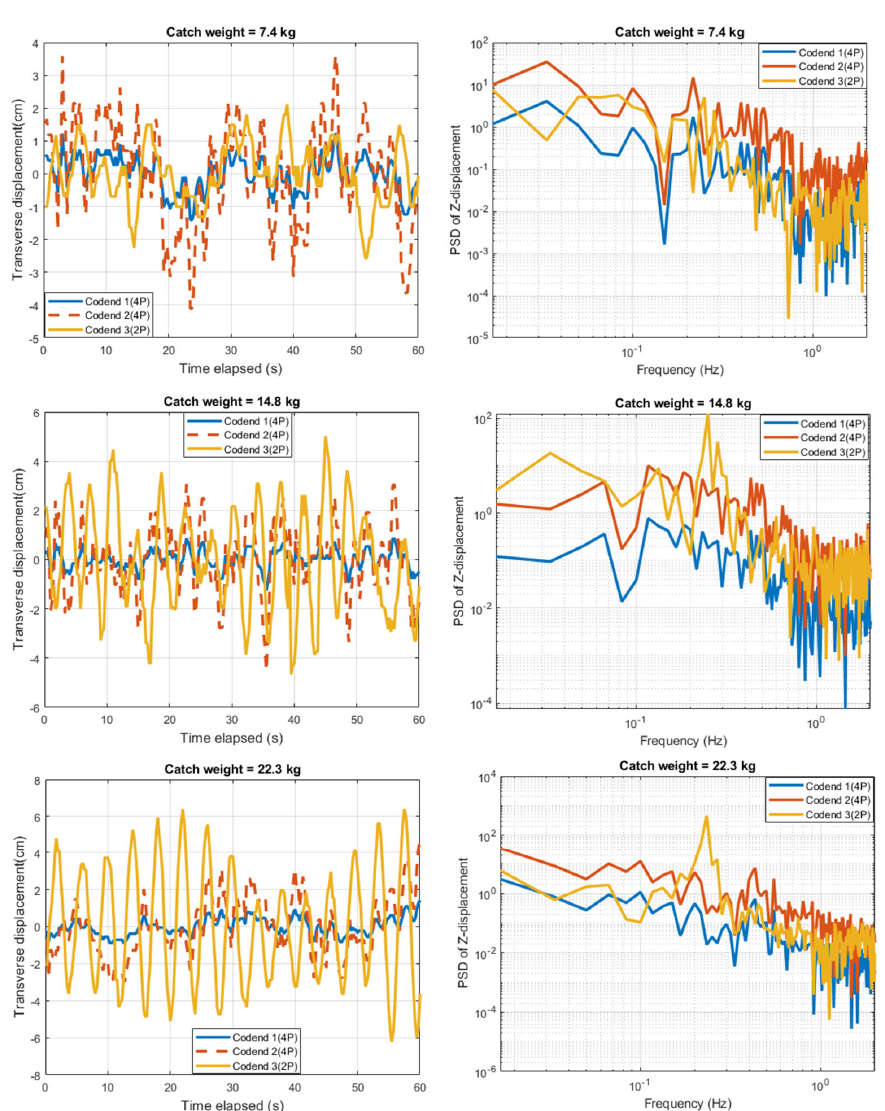
Figure 11. Fluctuations of the z-structure motion of the three codends ( left ) associated to the power spectral density (PSD) representation (in a log–log scale) ( right ) at different catch weights.